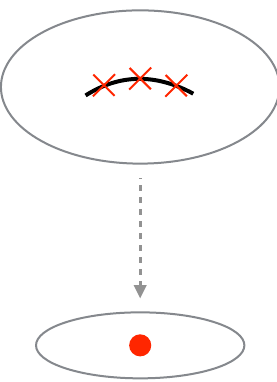
Figure 10 . Partial resolution of the sixfold family of versally deformed ALE spaces of type C 2 =D 4 = Spec R , with R = C [ x; y; z ] = ( x 2 yz ( y + z )). The base of the (cid:12)bration is the deformation space (cid:0) parametrized by ( T 0 ; : : : ; T 3 ), whereas the (cid:12)ber is parametrized by ( x; y; z ). Over the red locus (which may be a nontrivial subvariety of the base) the (cid:12)ber degenerates: we only resolve the black node in the colored D 4 Dynkin (see (cid:12)gure 7), corresponding to the two-dimensional vertex in (cid:12)gure